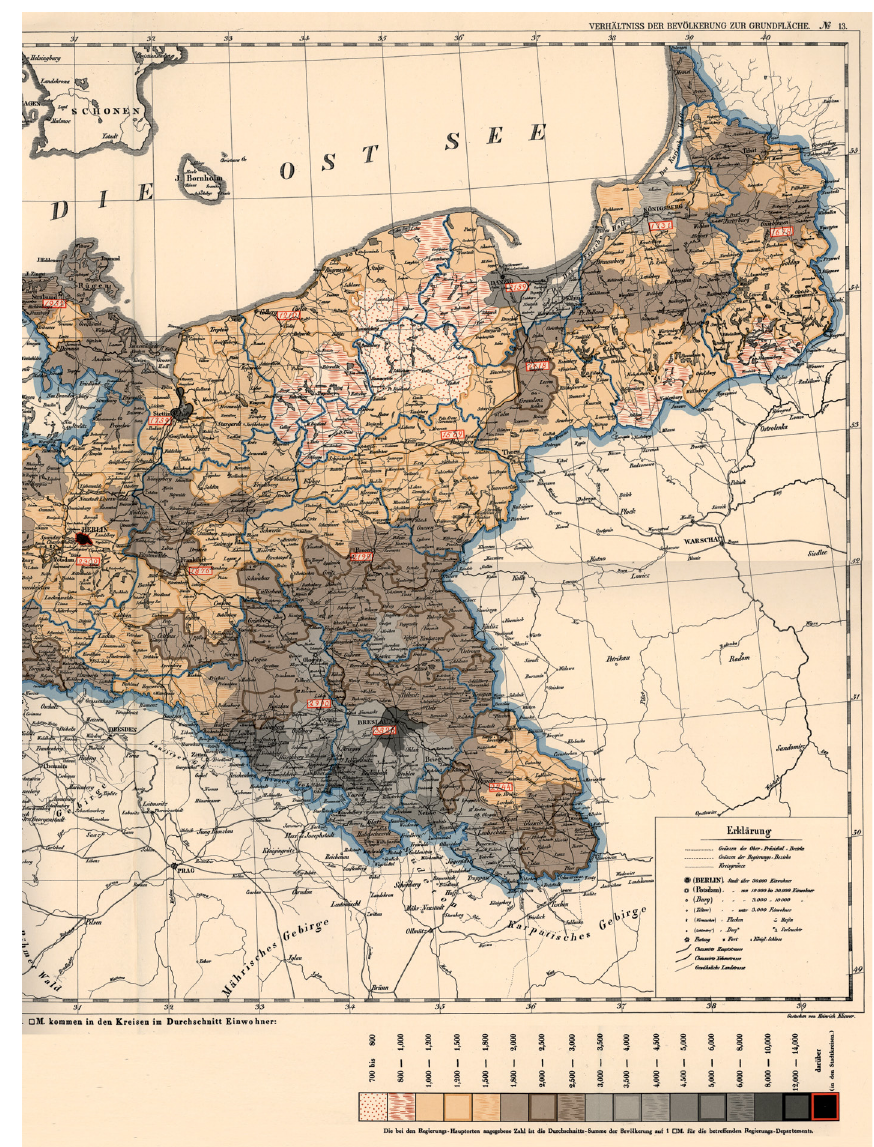
Fig. 8. A map section from Administrativ-statistischer Atlas vom Preussischen